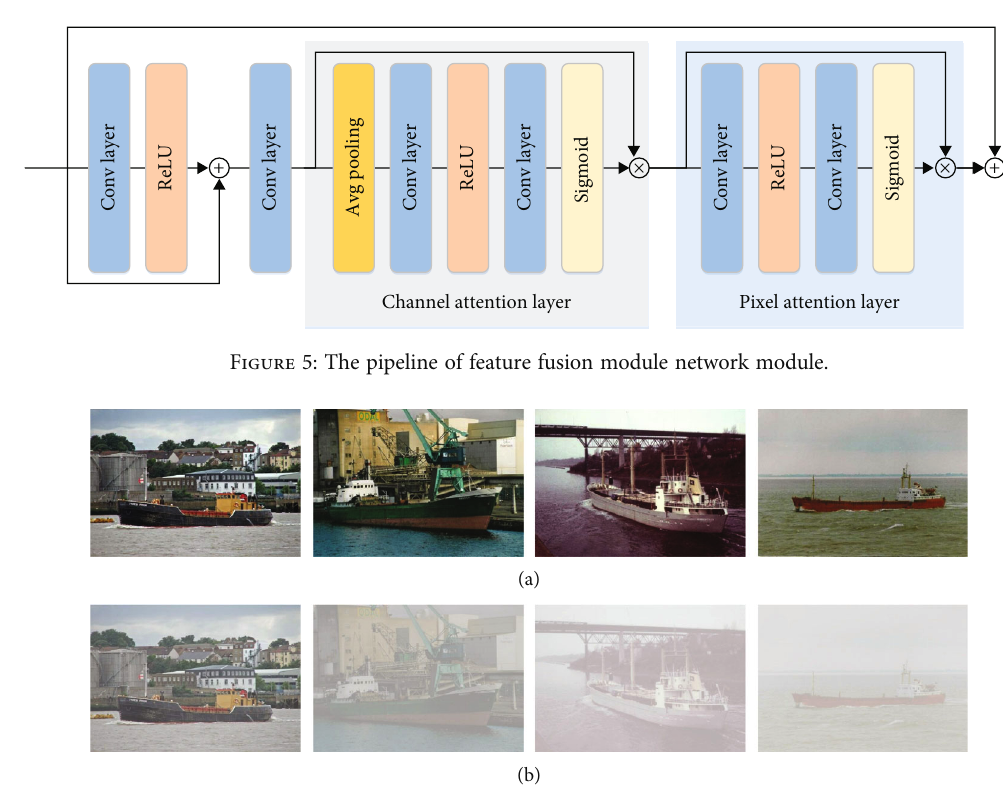
Figure 6: Examples of synthetic hazy images. (a) Original. (b) Synthetic